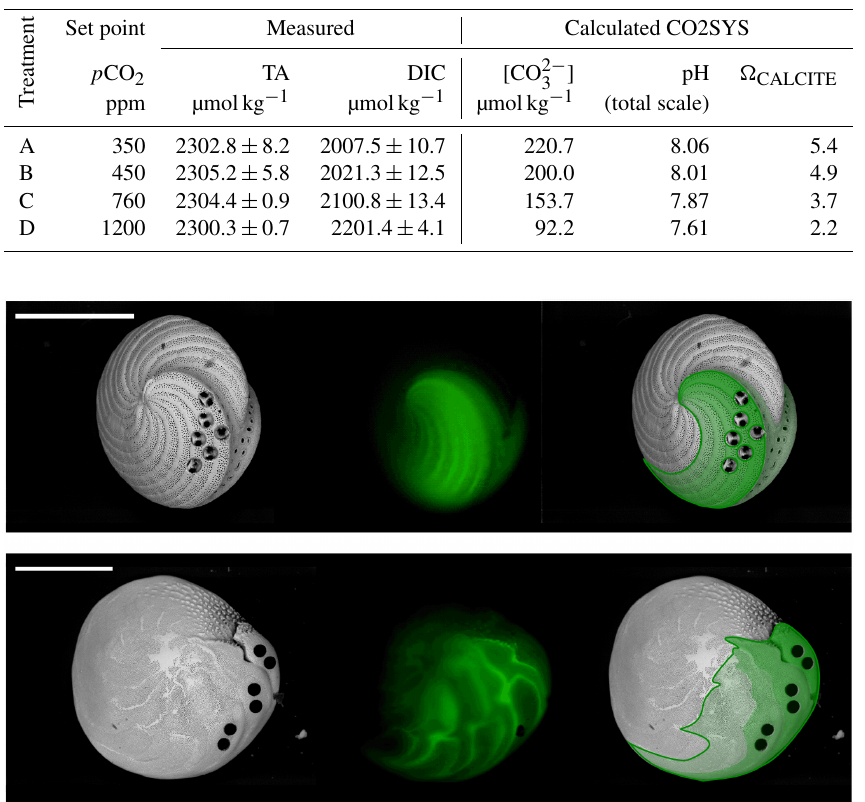
Table 1. Carbon parameters (TA ,total alkalinity, n = 2; DIC, dissolved inorganic carbon, n = 2) with (relative) standard deviation of the culture water per treatment of the p CO 2 experiment. CO2SYS was used to calculate seawater carbonate ion concentration, calcite saturation state and pH from measured TA and DIC.